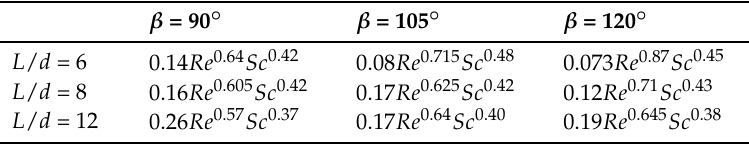
Table 3. Sh as function of Re and Sc for different feed spacer geometries